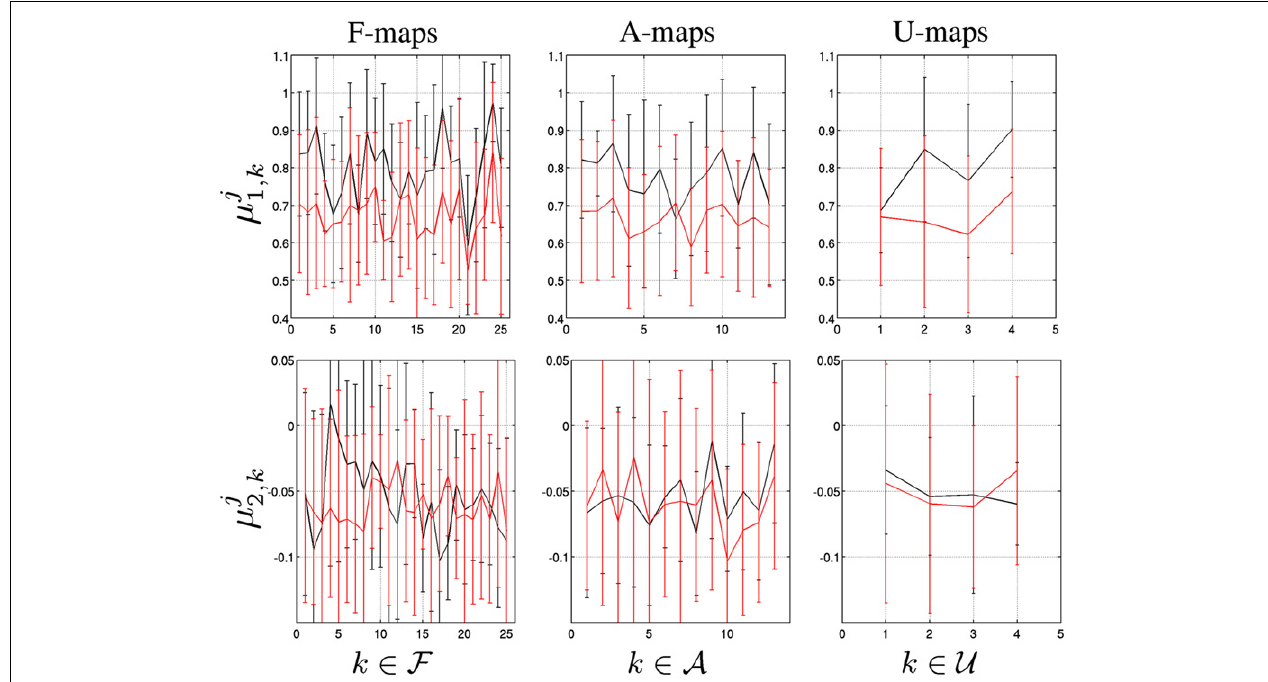
(top), μ j (bottom) specific to F/A/U-maps defined inTable 1. Black 1 , k 2 , k